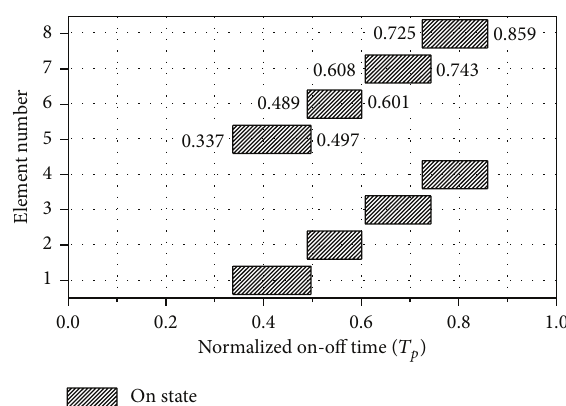
(𝑚) D Figure 6: The optimized time sequence for the two subarrays.